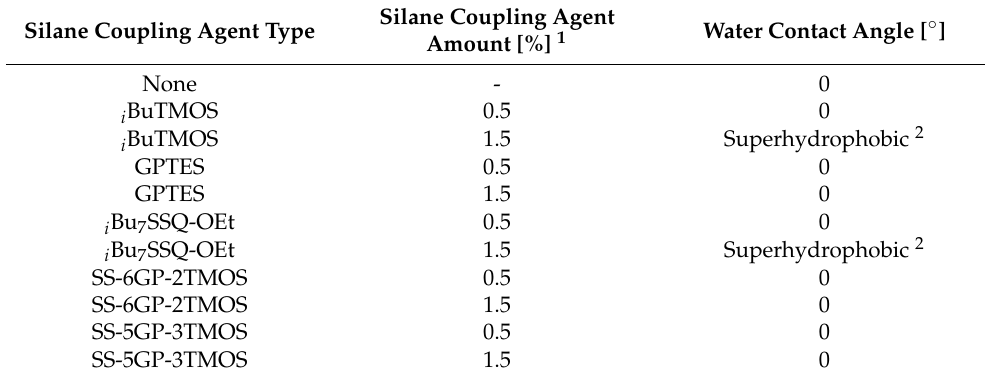
Table 3. Water contact angles of TiO 2 modified with the studied silane coupling